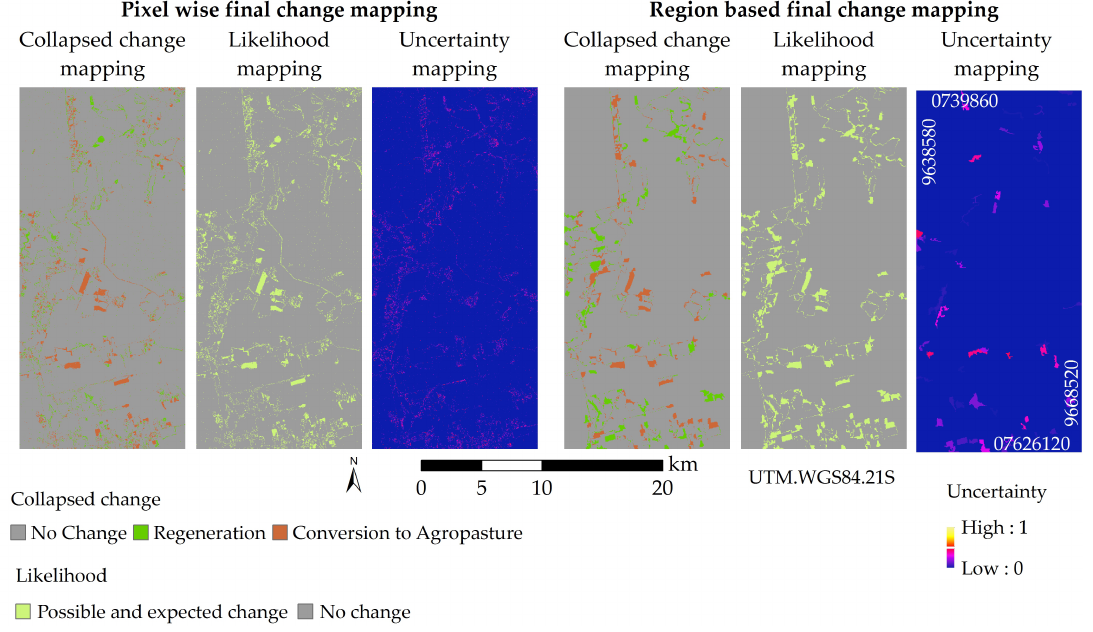
Figure 14. Final change mapping and associated quality mappings for L3